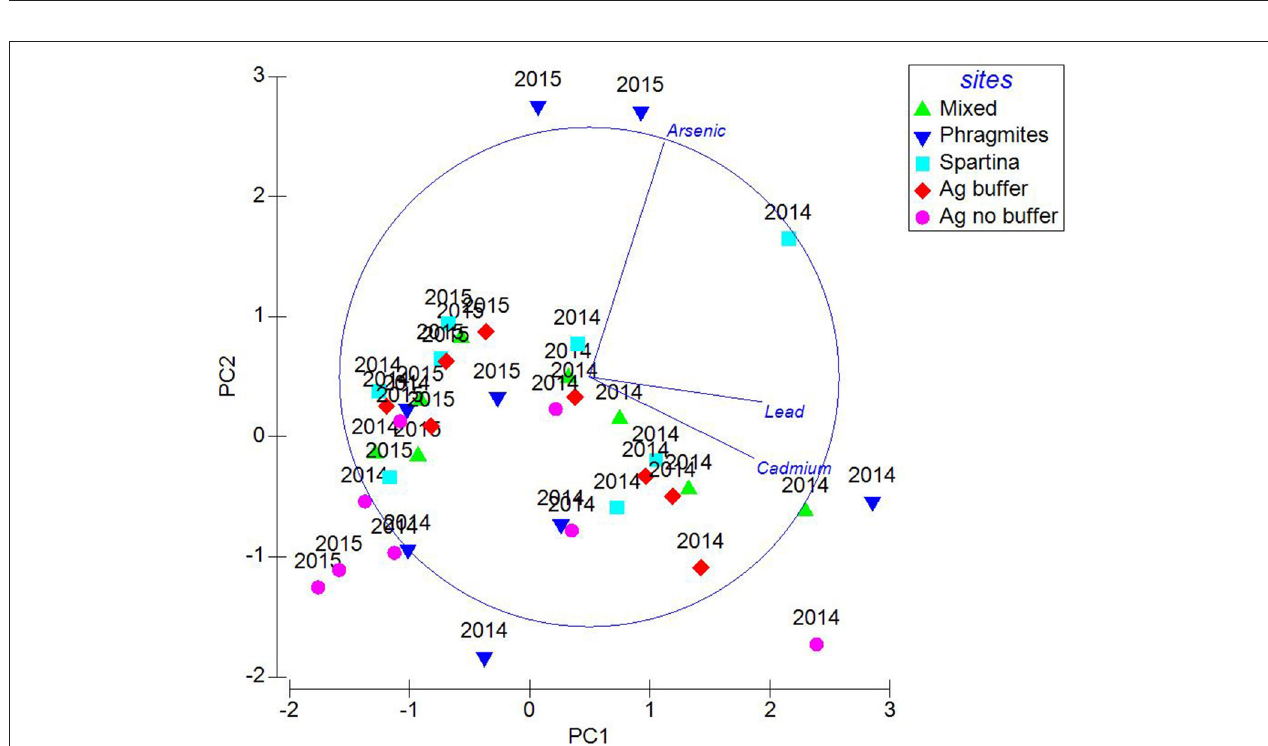
FIGURE 7 | Principal component analysis of heavy metals at the marsh grass sites for the years 2014 and 2015. confirms that the heavy metal concentrations in June are different from those in the other months. The results from MDS analysis are in consistence with the PCA